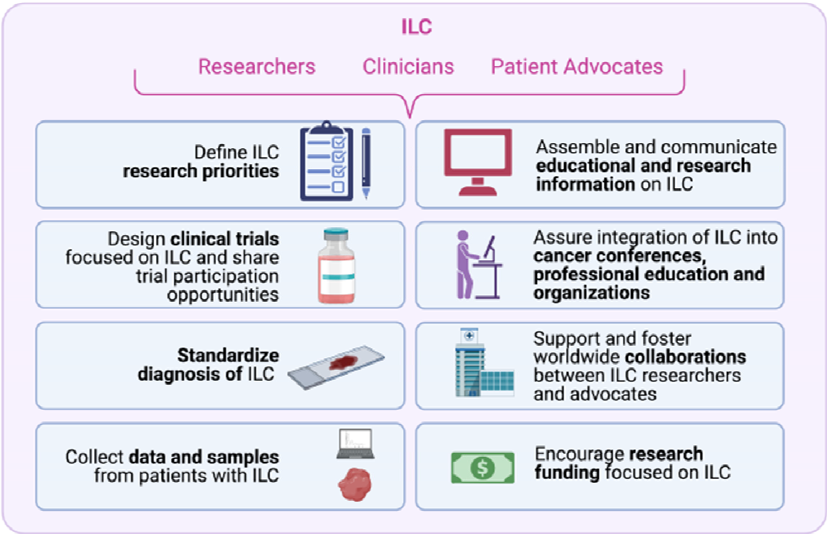
Figure 2. Challenges and opportunities in ILC research. Working together, researchers and cli- nicians can make progress to overcome challenges and advance research into